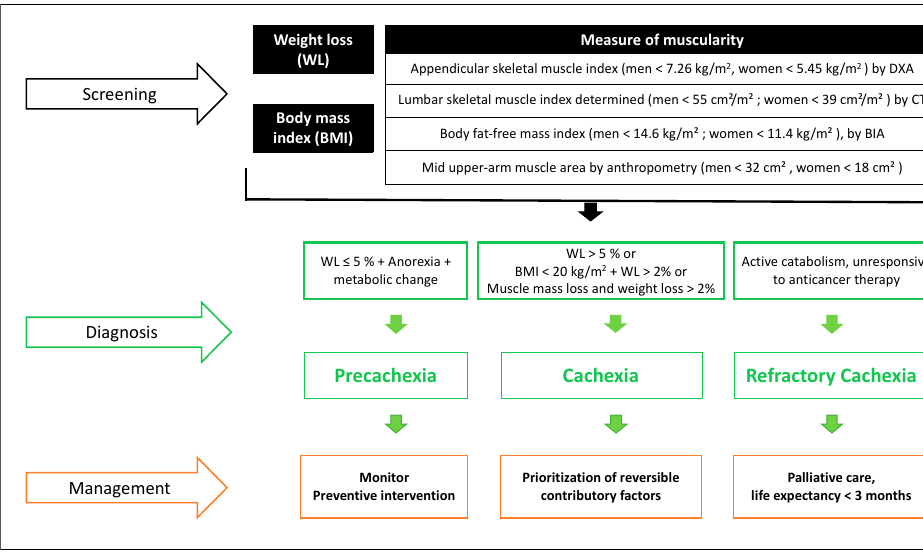
Figure 4. Cancer cachexia approach by Fearon et al. [12]. Abbreviations: DXA: Dual-energy X-ray Absorptiometry. CT: Computed Tomography. BIA: Bioelectrical Impedance Analysis.